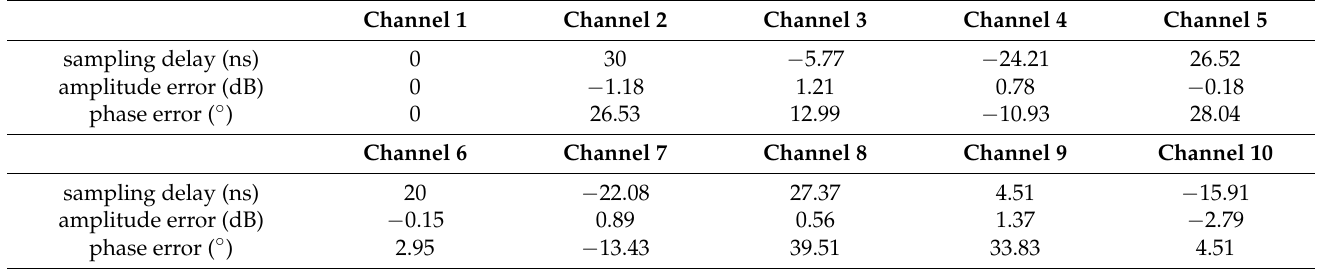
Table 2. Preset value of amplitude, phase and time delay bias of multiple-channels SAR. Channel 1 Channel 2 Channel